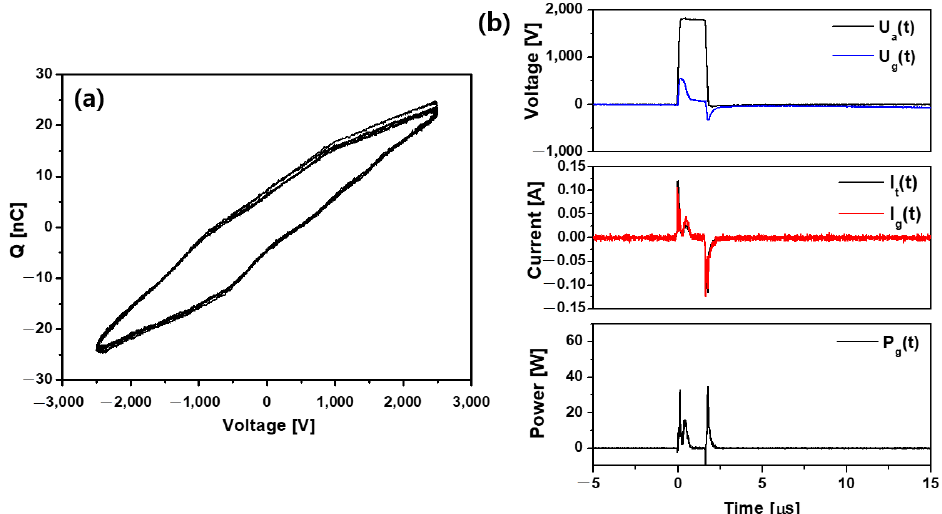
Figure 2. ( a ) Lissajous figures of the discharge. ( b ) Voltage and current waveforms and instantaneous power consumed by the discharge at the applied voltage of 1.7 kV pp , 50 kHz, duty ratio 8%. U a (t) is the applied voltage to the DBD cell, and U g (t) is the voltage across the discharge gap. I t (t) is the total current through the DBD cell, and I g (t) is the discharge (conduction) current in the gap. The instantaneous power is P g (t) = U g (t) × I g